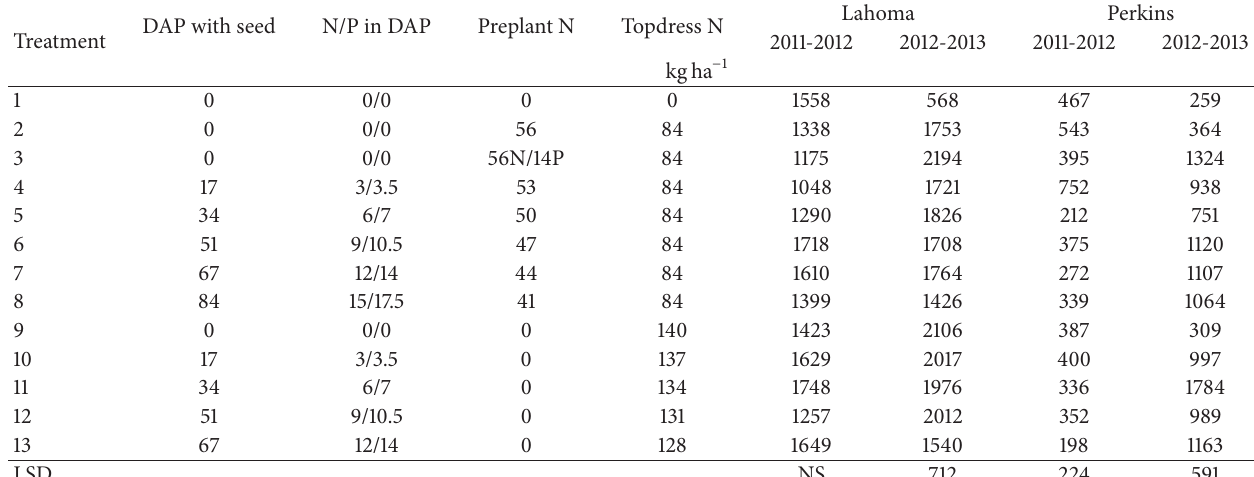
Table 3: Canola grain yield as influenced by seed-placed diammonium phosphate (DAP) and nitrogen (N) application method at Lahoma and Perkins, OK, in